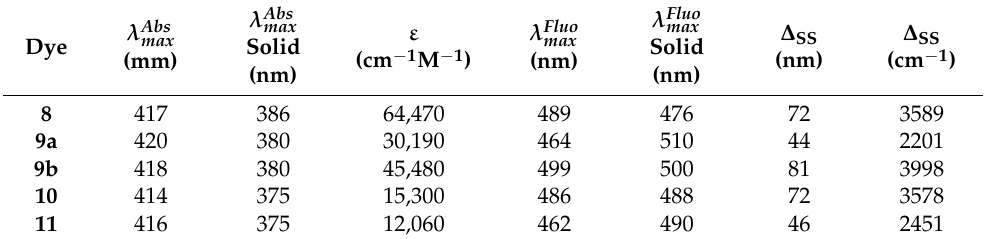
Table 1. Spectroscopic data for compounds 8 – 11 in acetonitrile solution (absorption and fluorescence emission maxima, molar extinction coefficients, ε , and Stokes shift, ∆ SS ) and absorbed in TiO 2 films (absorption and fluorescence emission maxima) at 293 K.